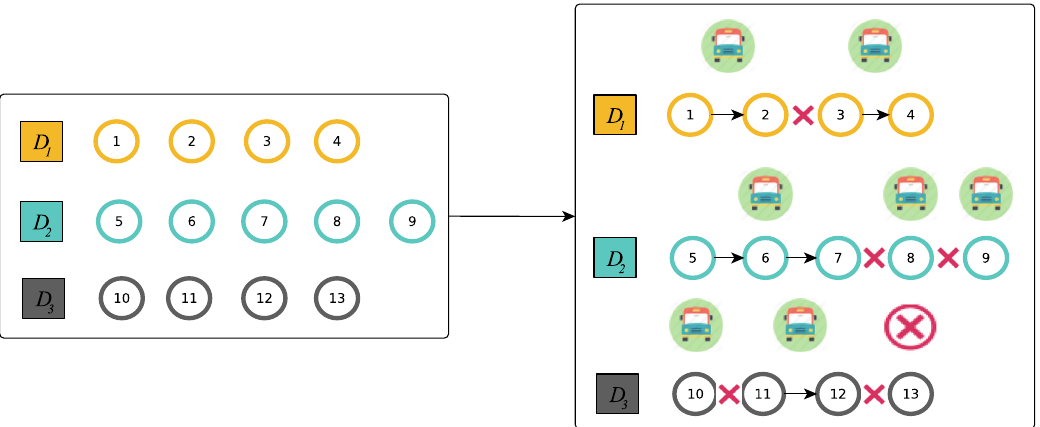
Fig. 3. Construction of itineraries for each depot’s (cid:1830)